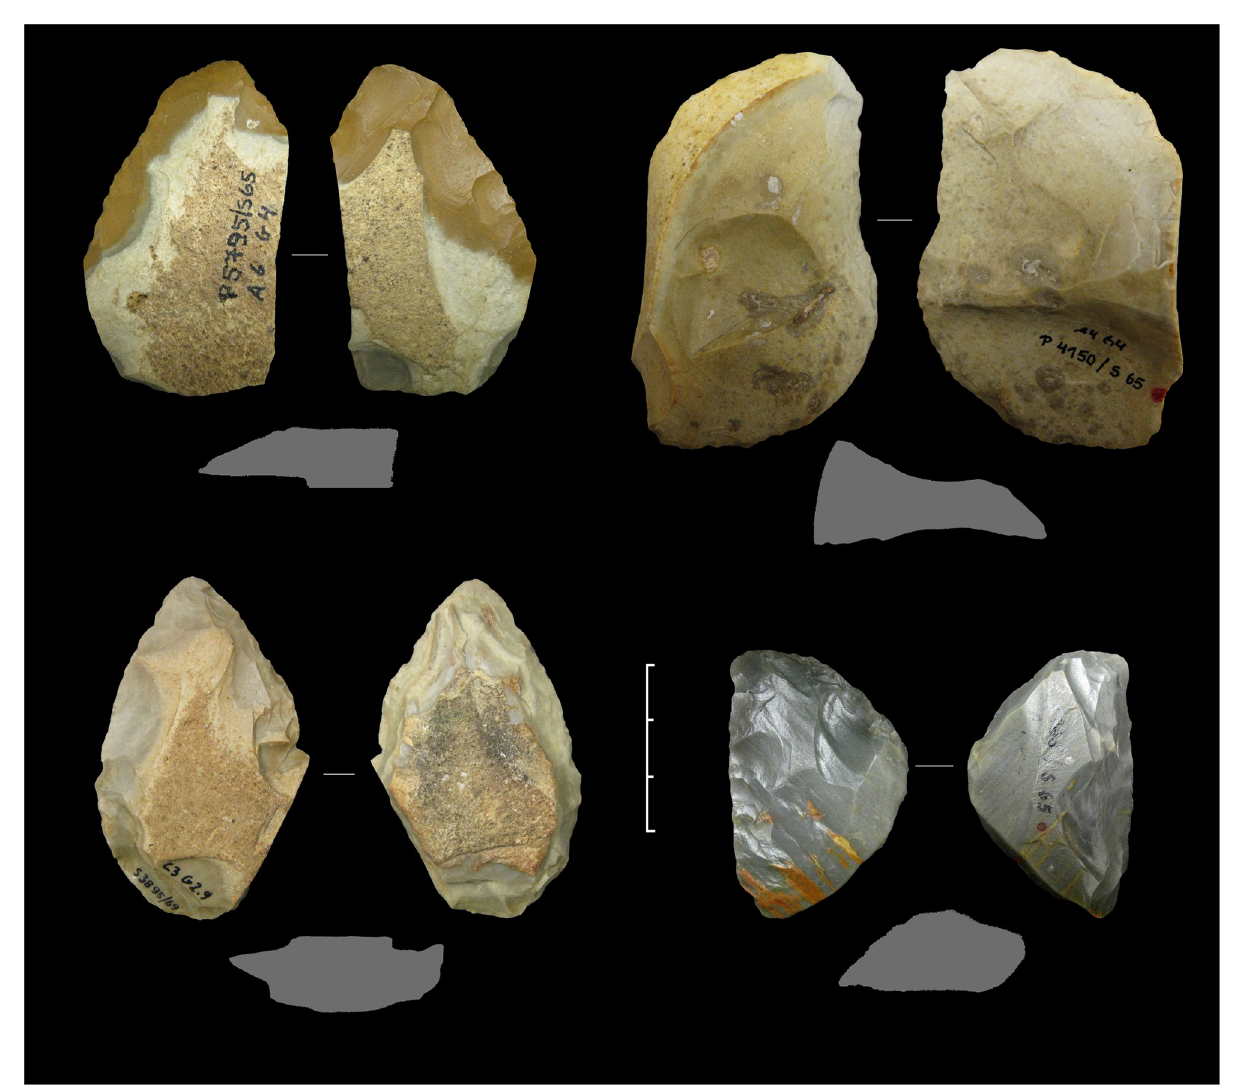
Fig 7. Keilmesser from Sesselfelsgrotte G-Complexes; from the top left: P5795/S65; P4150/S65; S3895/69; P2965/S65.